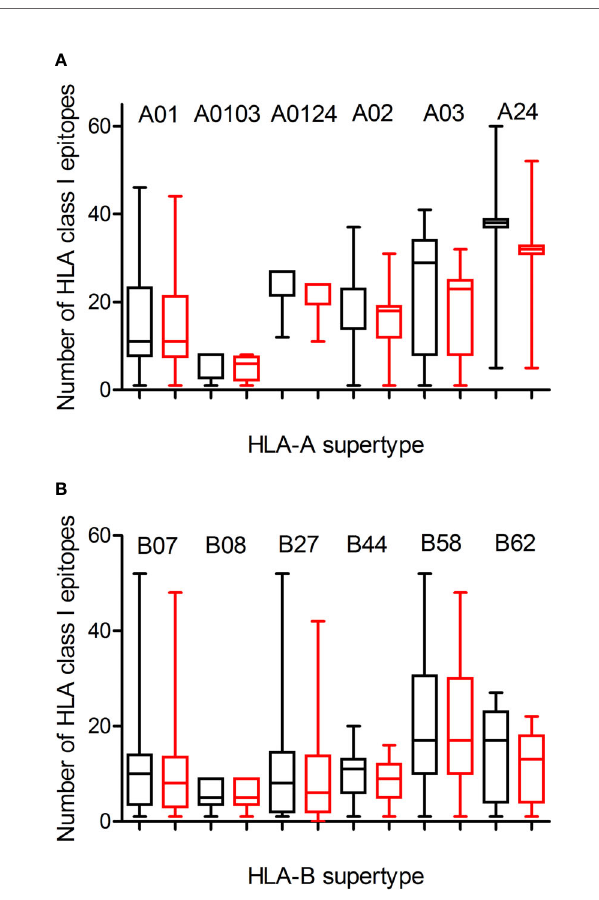
FIGURE 1 | Average number of epitopes in the Wuhan-1 and Omicron spike protein sequences predicted for HLA class I alleles including in the 12 HLA class I supertypes. The median value is indicated. Box limits indicate the interquartile range. Whiskers are adjusted to maximal and minimal values. The number of epitopes in the Wuhan-1 (black) and Omicron (red) strains predicted for HLA class I alleles including in the 6 HLA-A and 6 HLA-B supertypes are depicted in panels (A, B) ,